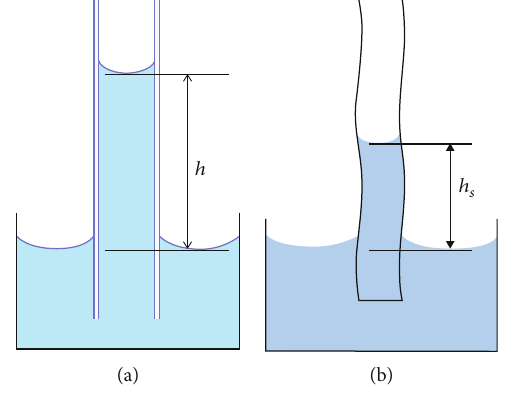
Figure 6: Imbibition models. (a) Traditional model. (b) New